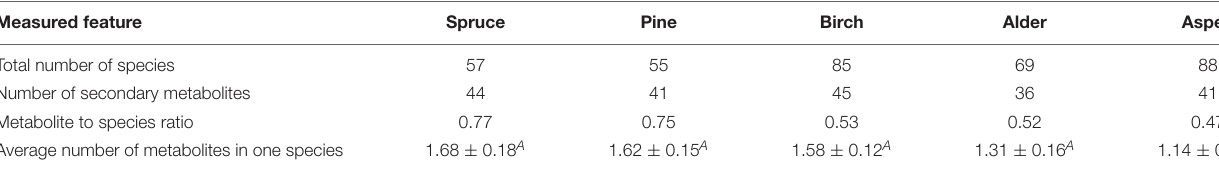
TABLE 2 | Species and secondary metabolite diversity on different phorophytes. Measured feature